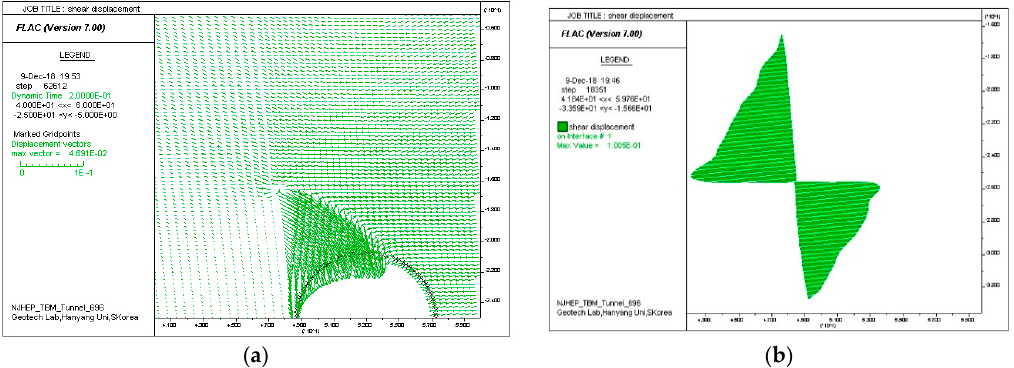
Figure 8. Shear displacement: ( a ) displacement vectors in the rock mass surrounding Tunnel 696; ( b ) shear displacement in the shear zone.